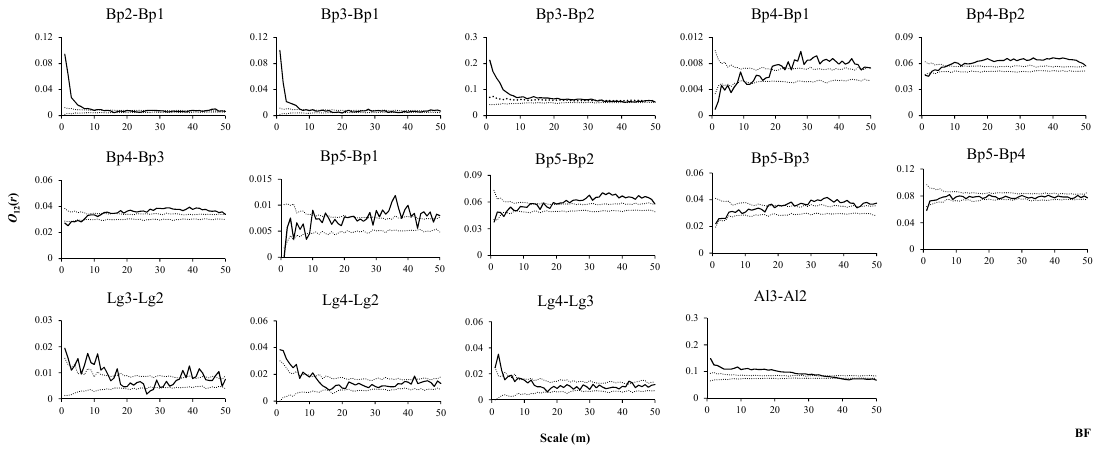
Figure 5. Spatial associations of tree species in BF. O 12 ( r ) values indicate the spatial associations between the same tree species or different tree species at different stages, thin dashed lines indicate the upper and lower limits of the 95% simulation envelope of the bivariate toroidal shift null model. Points above the upper envelope indicate positive associations, points between the envelopes indicate no associations, and points below the lower envelope indicate negative associations (From Figure 5 to Figure 10).